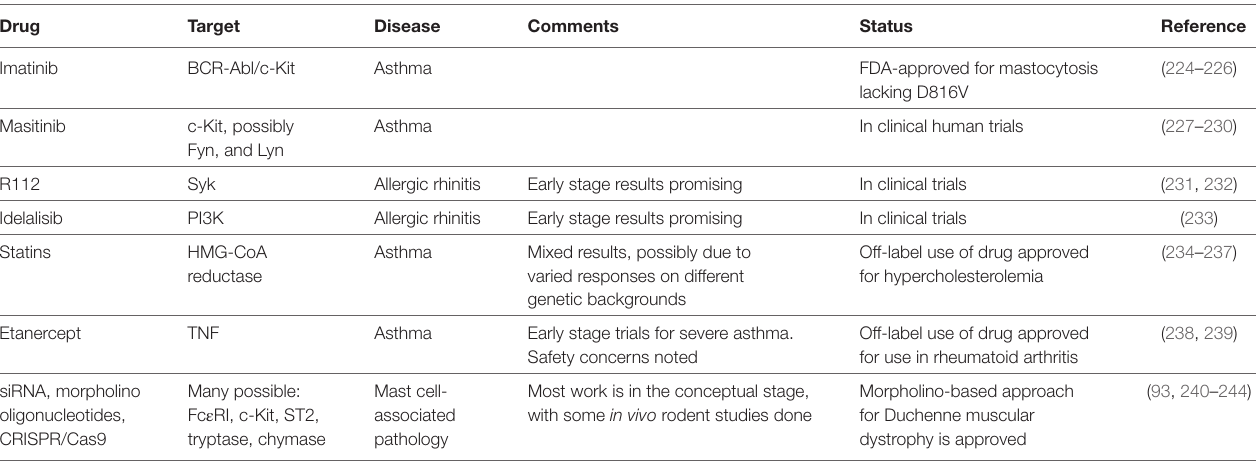
TABLe 1 | Potential therapies for mast cell-associated